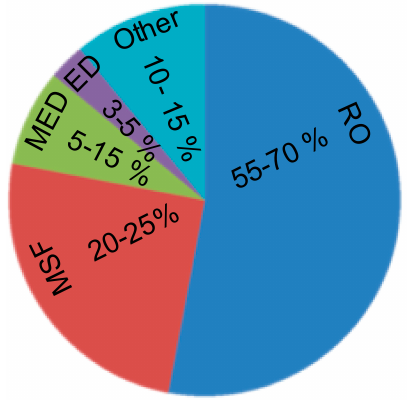
Figure 5. Contribution of different techniques in the current water desalination market.